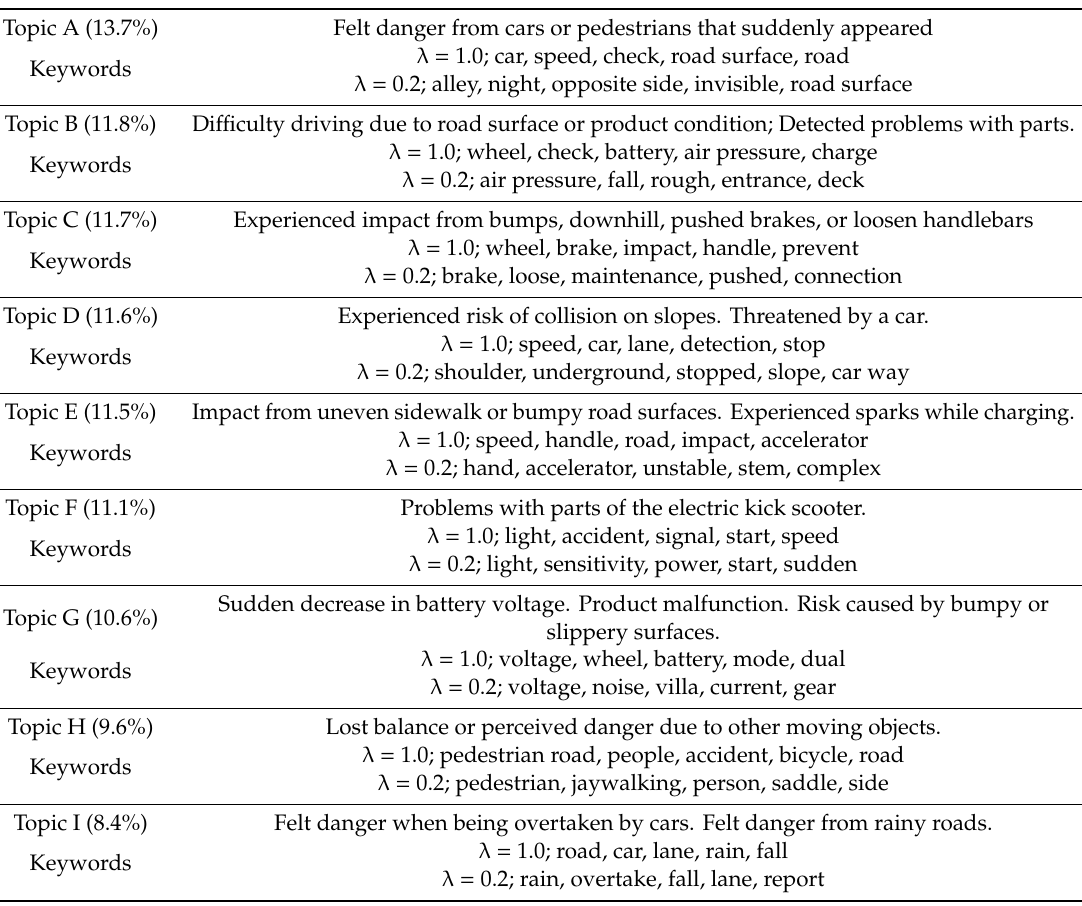
Table 6. Nine topics and keywords of risk episodes classified using latent Dirichlet allocation (LDA). Topic A